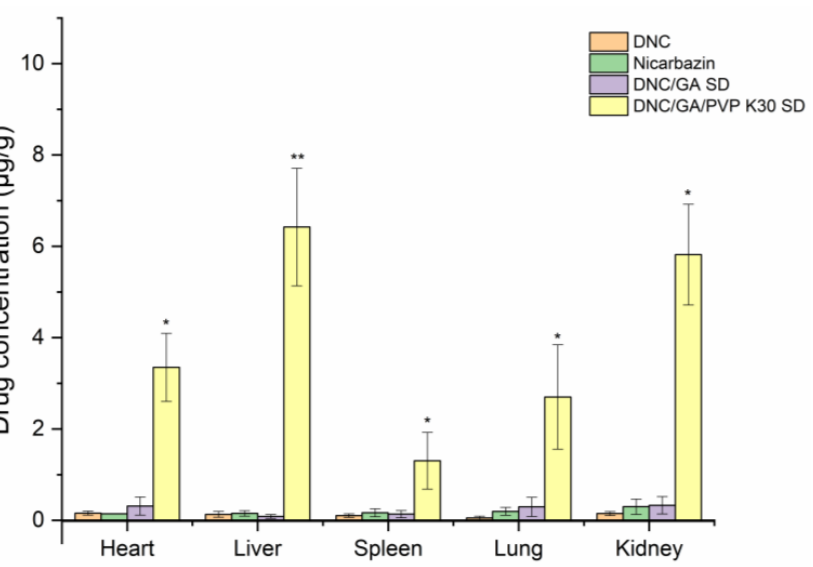
Figure 13. DNC concentration in tissue after oral administration (n = 6) versus DNC, * p < 0.05, ** p < 0.01.